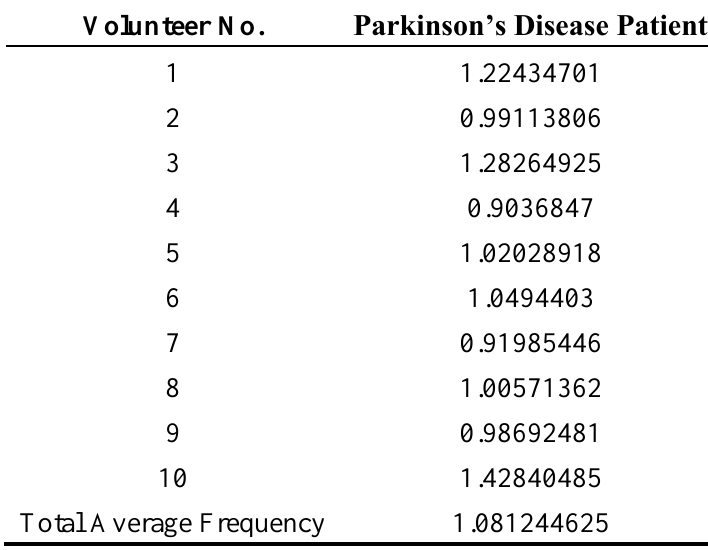
Table 4. Dorsum manus vibration frequency for Parkinson patients.